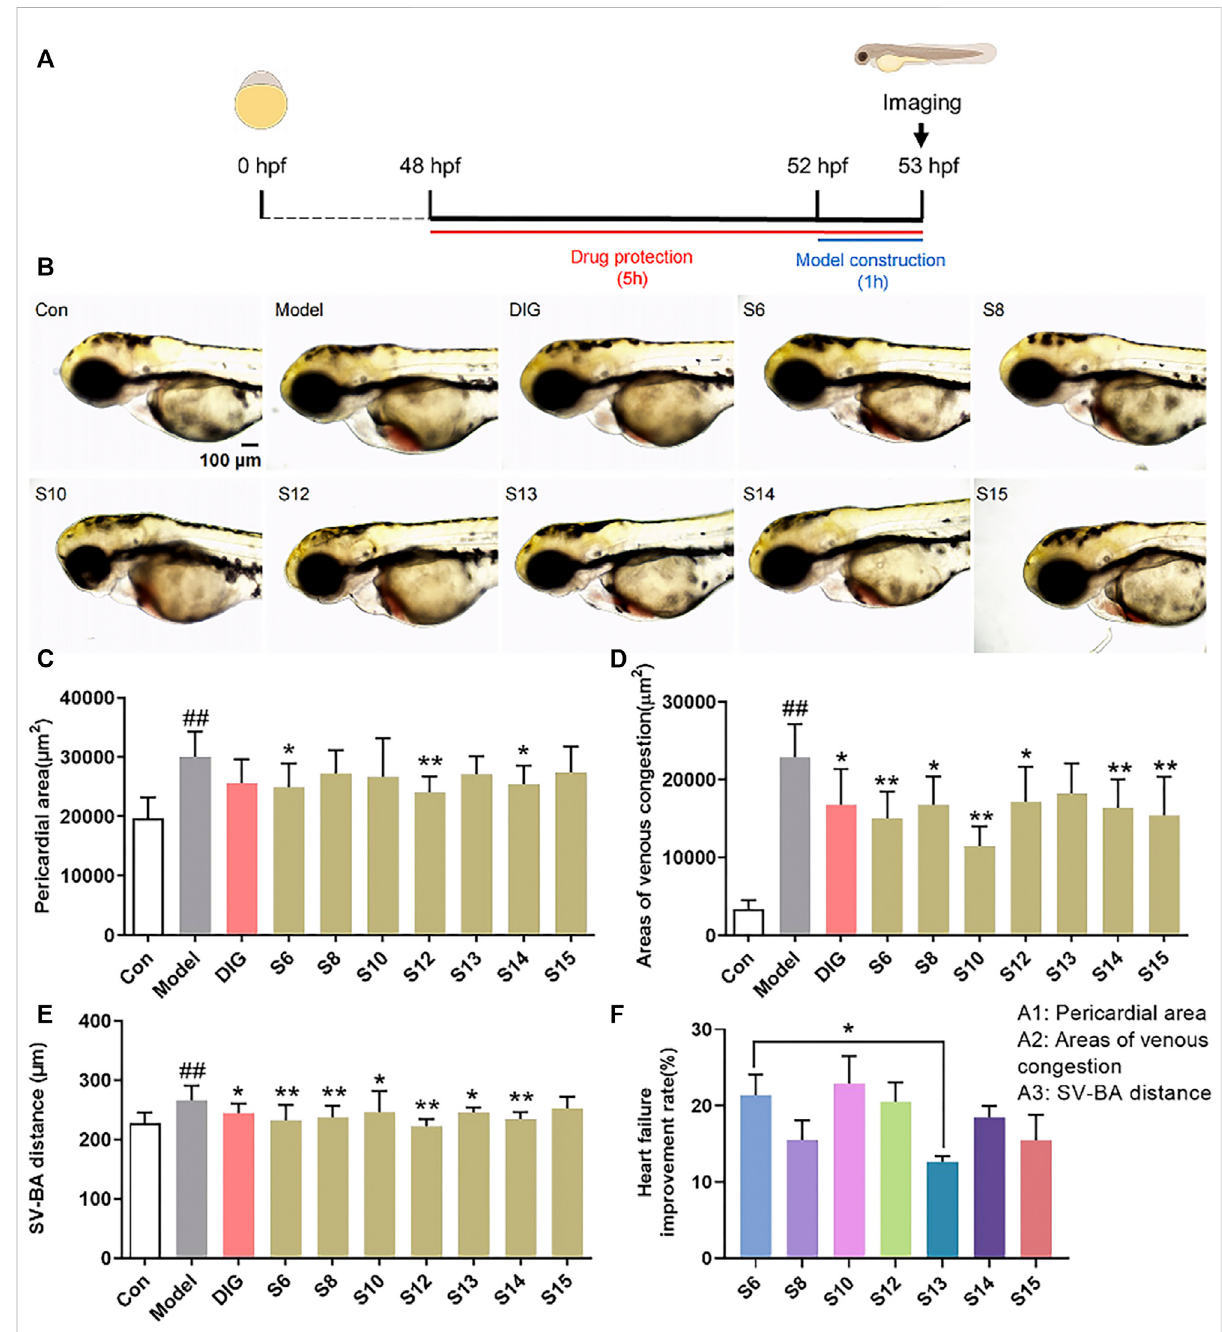
FIGURE 1 Comparisonoftheanti-heartfailureactivitiesofAGcollectedfromdifferentregions. (A) Diagramofdrugtreatmentinthezebra fi shheartfailure experiment; (B) phenotypic micrograph of the zebra fi sh in the heart; (C) statistical results of the pericardial area of the zebra fi sh heart. n = 10; (D) statistical resultsofthevenouscongestionareaoftheheartinzebra fi sh. n =10; (E) statisticalresultsofSV – BAinthezebra fi shheartsinallgroups. n = 10; and (F) comparison of the improvement rate of heart failure of AG samples from different regions. Heart failure improvement rate = (A1+A2+A3)/3, A = ( Φ -a)/ Φ *100%, Φ : Mean values of the model groups, (A) values of sample groups; ## p < 0.01 vs. the control group; * p < 0.05 and ** p < 0.01 vs. the model